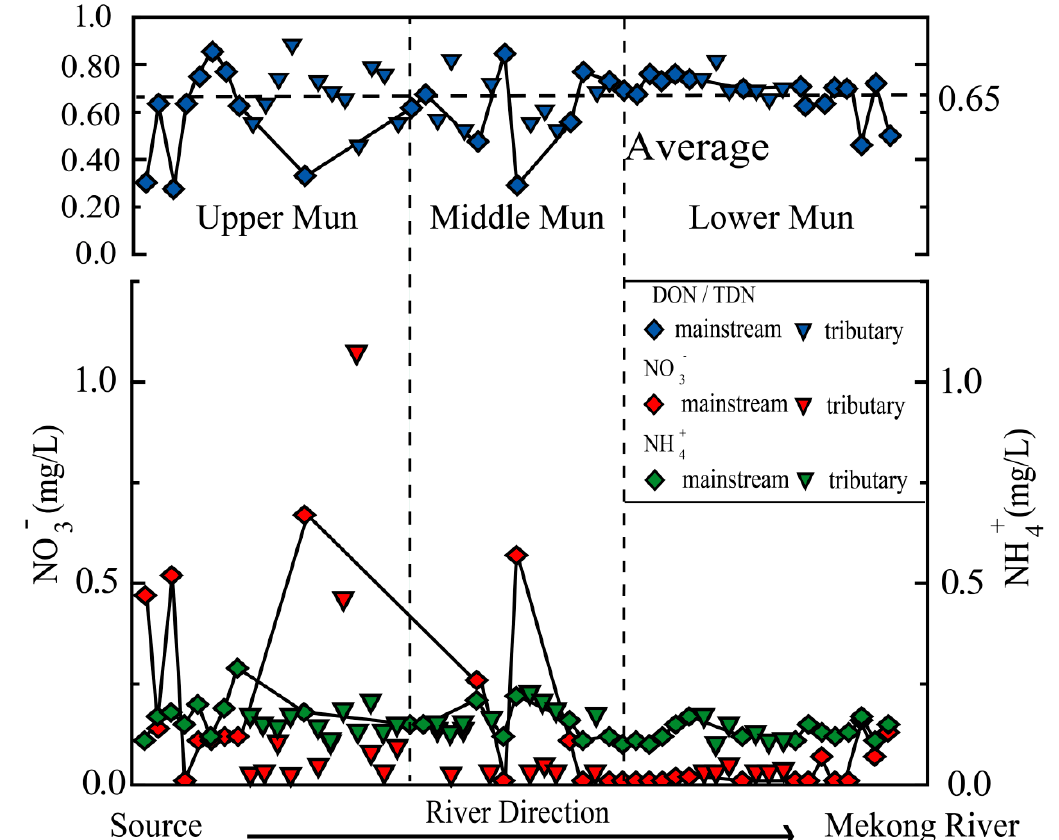
Figure 4. Spatial distributions of NO 3 − , NH 4+ , and the DON/TDN mole ratio in the Mun river.